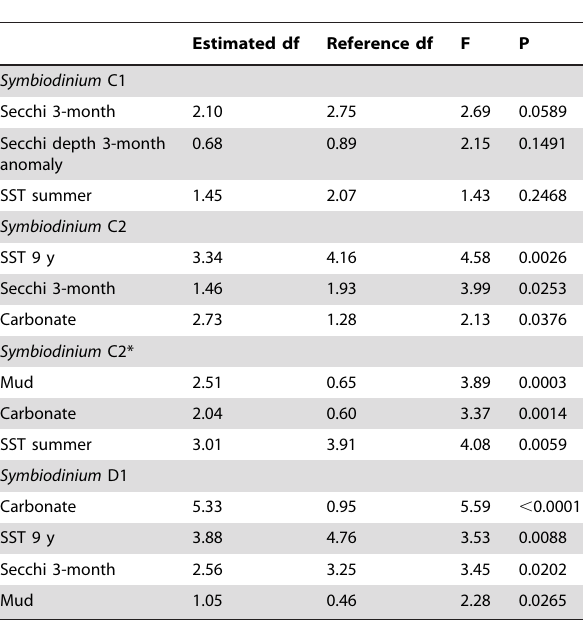
Table 3. Summary of GAMs to examine the environmental drivers associated with the distribution of dominant Symbiodinium types sampled at regional scales across the Great Barrier